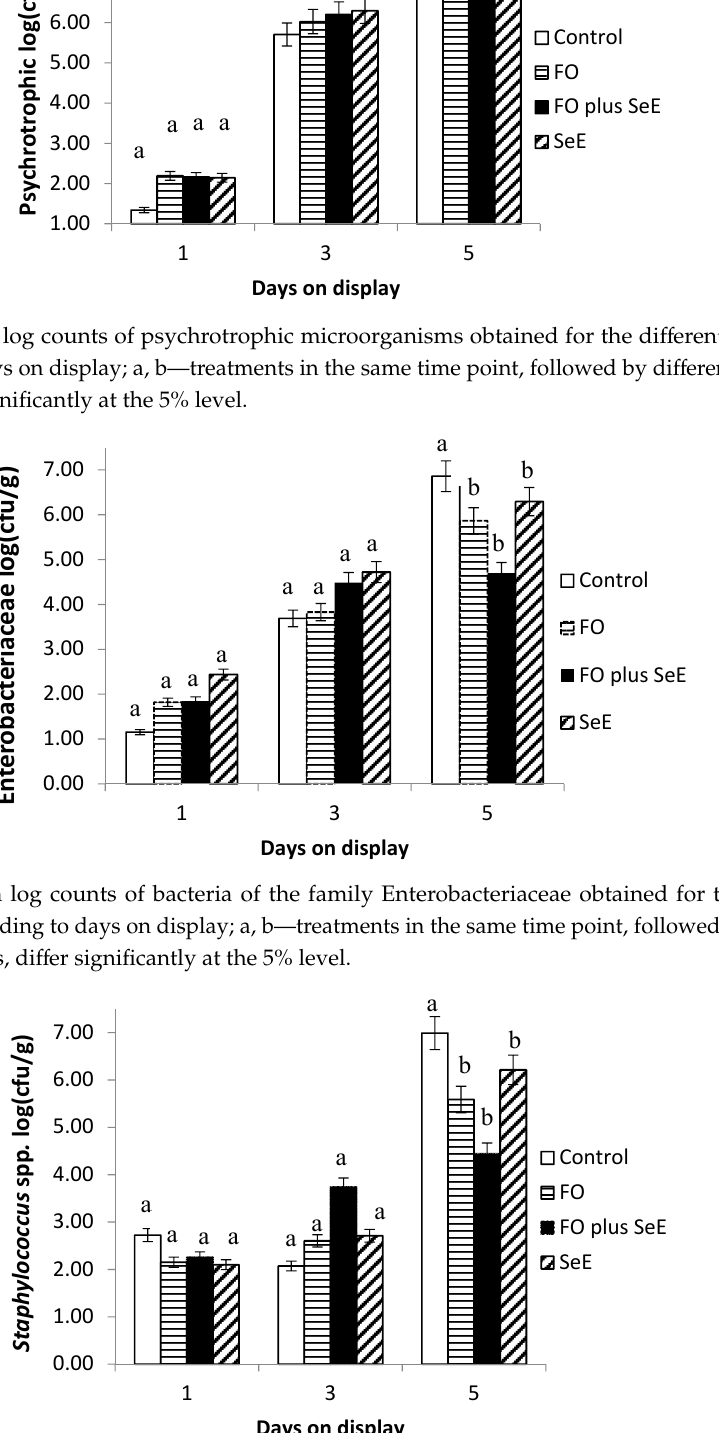
Figure 2. Mean log counts of psychrotrophic microorganisms obtained for the different treatments according to days on display; a, b—treatments in the same time point, followed by different lowercase letters, differ significantly at the 5% level.